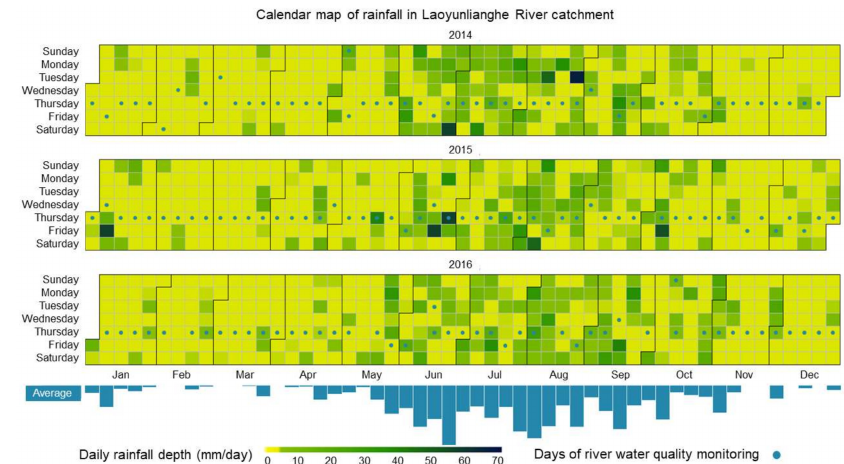
Figure 4. Calendar heat map of average daily rainfall depth in the Laoyunlianghe River catchment, as well as days of river water quality monitoring (blue circles). Darker colors in the calendar refer to more intense rainfall